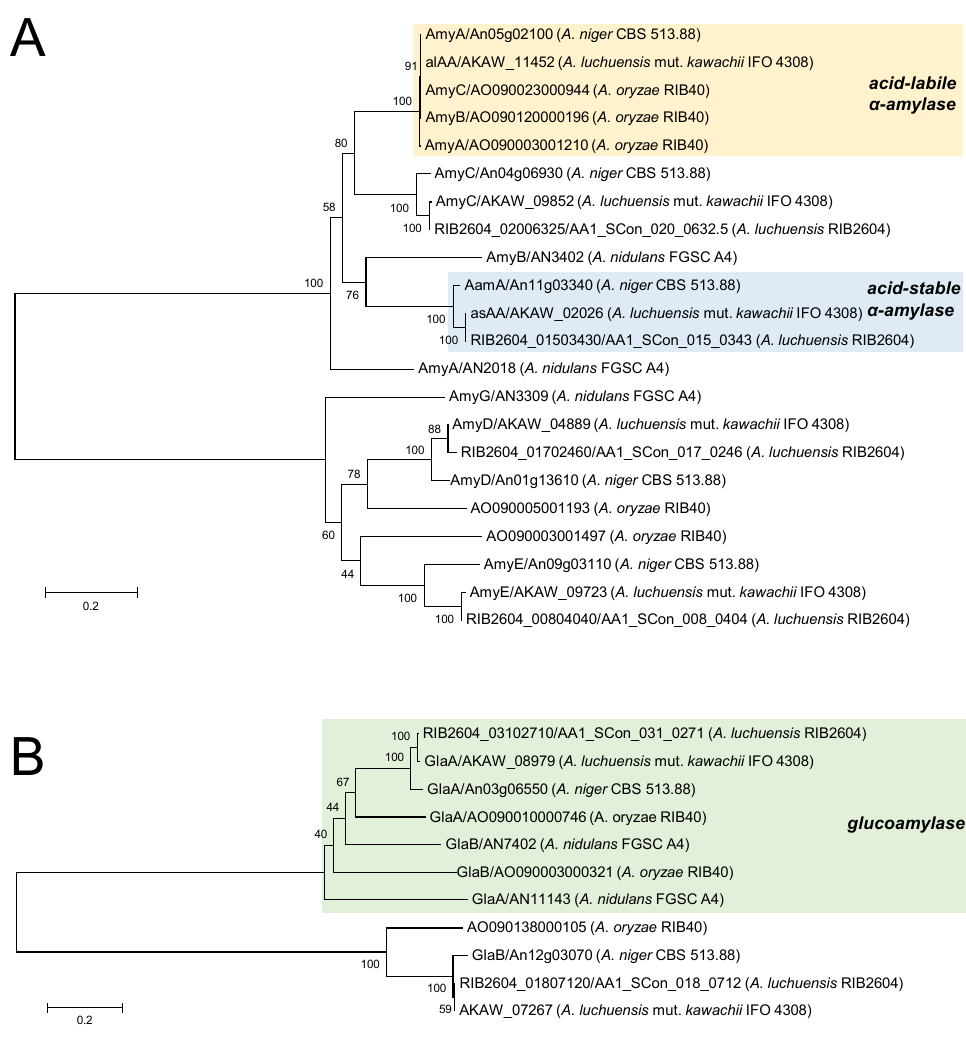
Figure 3. Phylogenetic tree of α -amylases ( A ), glucoamylases ( B ), and some homologs in Aspergillus oryzae RIB40, A. luchuensis RIB2604, A. luchuensis mut. kawachii IFO 4308, A. niger CBS 513.88, and A nidulans FGSC A4. The phylogenetic tree was constructed using the neighbor-joining method based on the alignment of amino acid sequences with pairwise deletion using MEGA v. 6 (http://www.megasoftware.net/ (accessed on 1 May